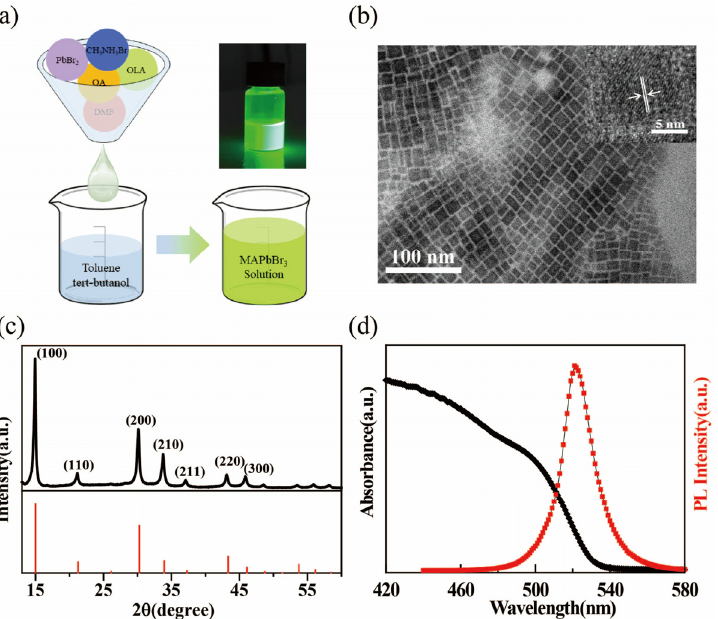
Figure 1. ( a ) Schematical illustration synthesis of MAPbBr 3 QDs; inset shows a photo of MAPbBr 3 solution under UV lamp excitation ( λ = 365 nm). ( b ) TEM images and ( c ) X − ray diffraction pattern of MAPbBr 3 QDs. ( d ) UV − vis absorption and PL emission spectra of a typical MAPbBr 3 QDs solution.